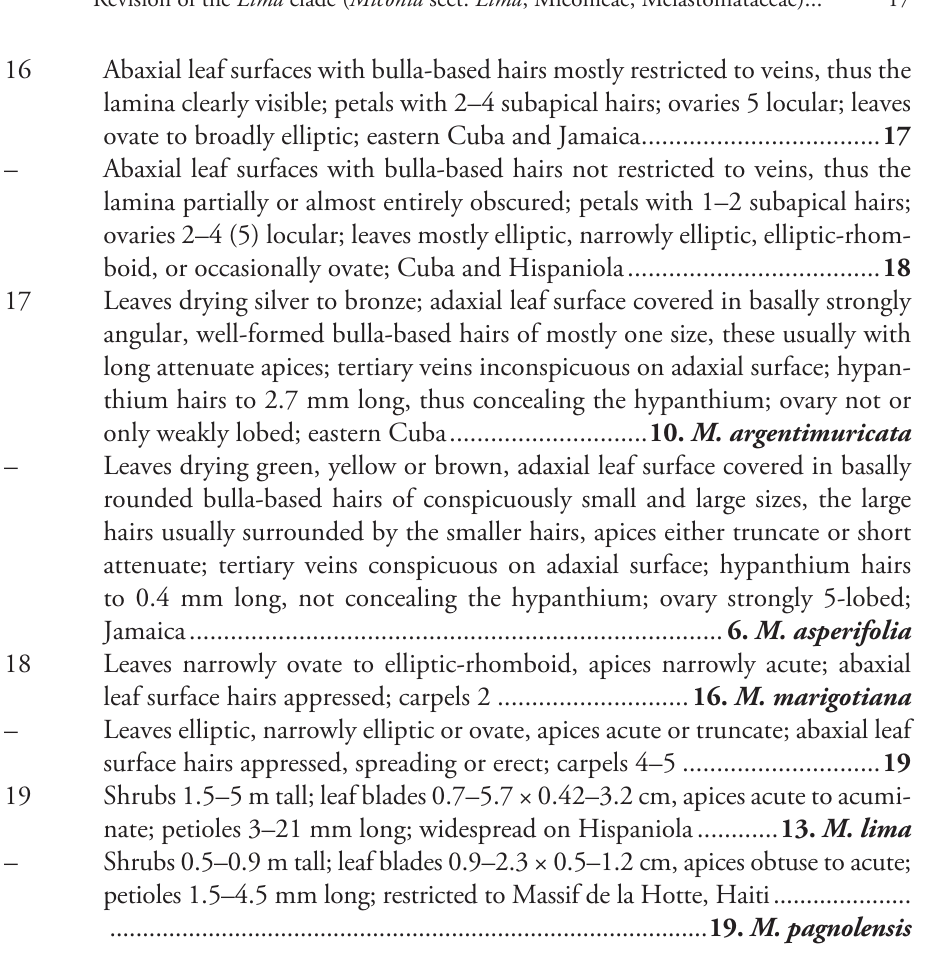
Taxonomic treatment 1. Miconia jashaferi Majure & Judd, J. Bot. Res. Inst. Texas. 7: 268. 2013. Figs 3, 9A–D Ossaea shaferi Britton & Wilson, Mem. Torrey Club 16: 92. 1920. Type: CUBA. Camp La Gloria, South of Sierra Moa, 24–30 Dec 1910, J.A. Shafer 8152 (holotype: NY! [NY00099714]; isotypes: A! [A00073129], CAS [CAS0003716]). Type. Based on Ossaea shaferi Britton & Wilson Description. Evergreen shrub, 1–1.5 m tall; stems round in cross section, not ridged, the internodes 0.4–9.5 cm long, stem indumentum of spreading to